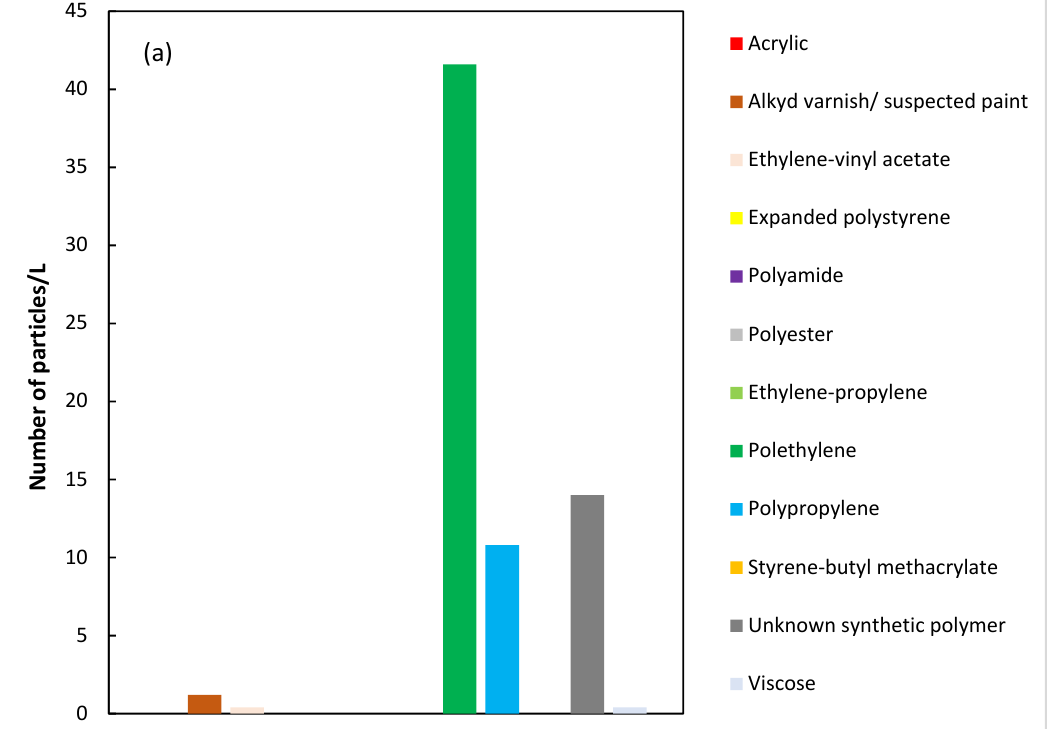
Figure 3. ( a ) Type and total concentration of microplastic particles in the untreated sample; ( b ) type and total concentration of microplastic particles in the treated sample. 3.2. Sand Filtration